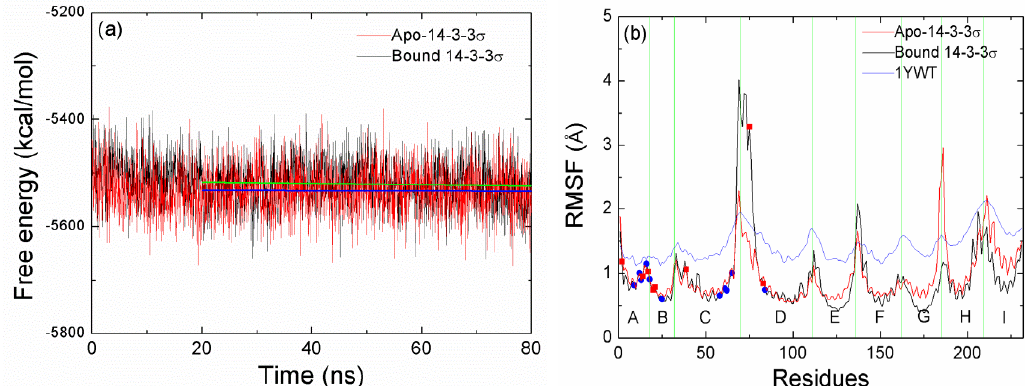
Figure 3. ( a ) Sum of gas-phase and solvation free energies calculated for 2000 snapshots of 14-3-3 σ protein extracted at 40 ps intervals from the MD simulations. The linear lines for the last 60 ns simulation time are colored in green and blue for apo-14-3-3 σ and bound 14-3-3 σ , respectively; ( b ) Root-mean-square fluctuation (RMSF) of the C α atoms versus residue number for a monomer of 14-3-3 σ obtained from the crystallographic structure and the last 60 ns MD simulation. The region of helices are divided with the green vertical line and labeled.